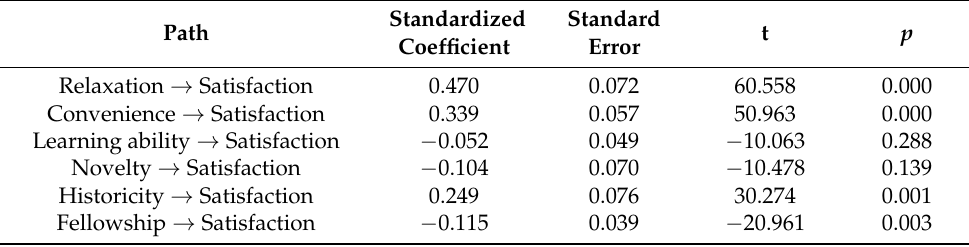
Table 5. Results of analysis of the relationship between motivation and satisfaction (full sample, n =